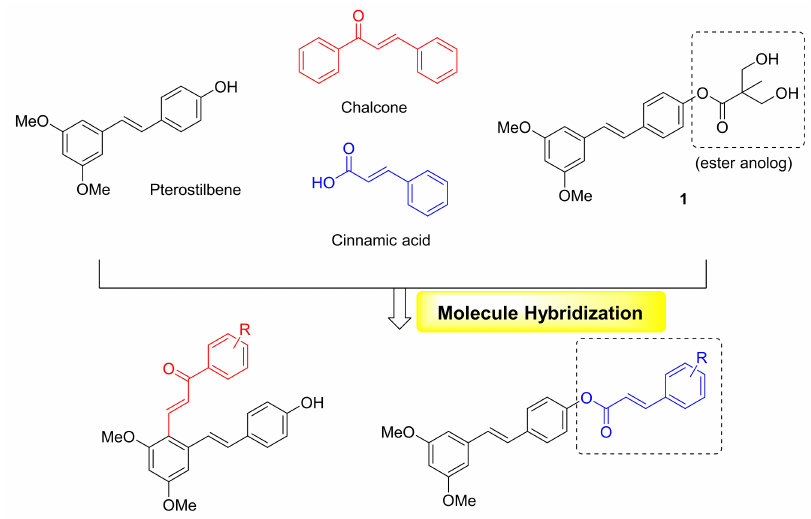
Figure 1. The design strategy of novel pterostilbene derivatives.